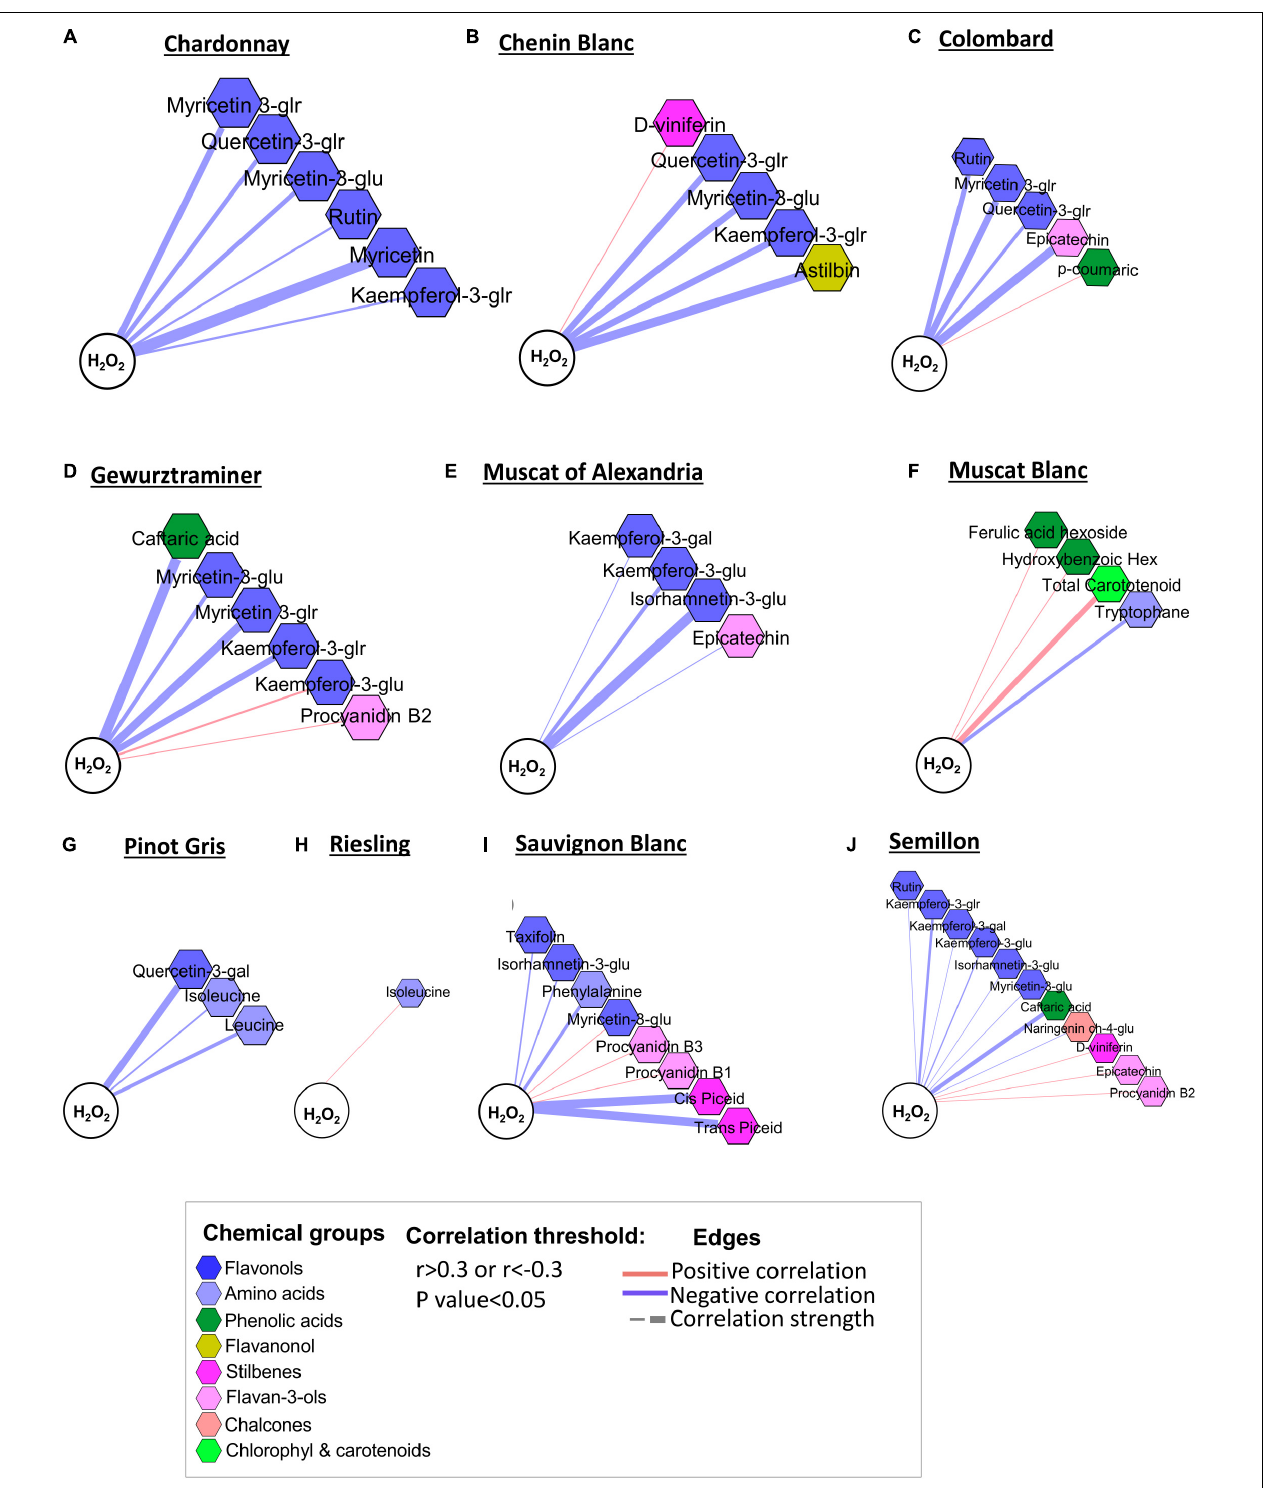
FIGURE 7 | Network visualization of correlations between H 2 O 2 and skin phenylpropanoids measured in 10 white grapevine cultivars (A–J) in 2017 and 2018. Metabolites are color-coded according to the chemical groups. The correlation analysis was performed using four biological replicates at the Mitzpe Ramon (MR) and Ramat Negev (RN) vineyards in each season; only significant correlations are presented. Positive correlations are shown as red edges, and negative correlations as blue edges. Correlations were based on Pearson’s method.